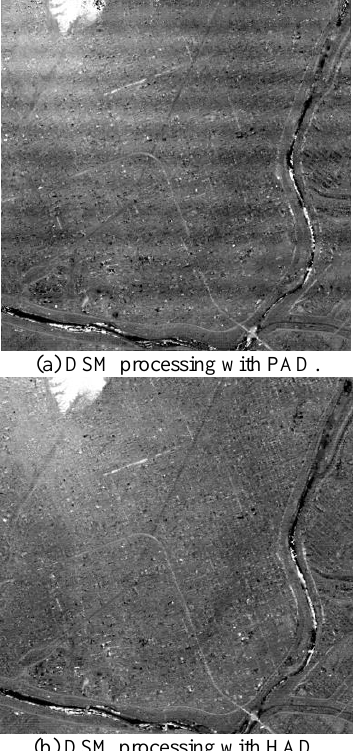
Figure 4. Comparison between the PRISM DSM processed with (a) PAD and (b) HAD (Takaku and Tadono, 2010).